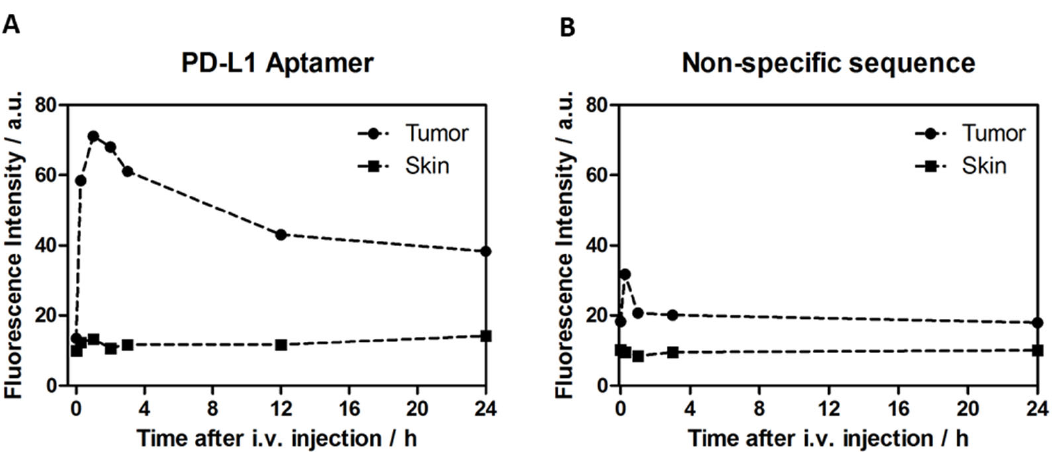
Figure 8. In vivo noninvasive tumor imaging with 2c2s-Cy5.5. PD-L1 aAPC/CHO-K1 (PD-L1 overexpressing) tumor bearing mice were injected intravenously with ( A ) Cy5.5-labeled 2c2s or ( B ) Cy5.5-labeled unspecific aptamer, and the fluorescence signal was monitored through the skin at tumor and adjacent sites.